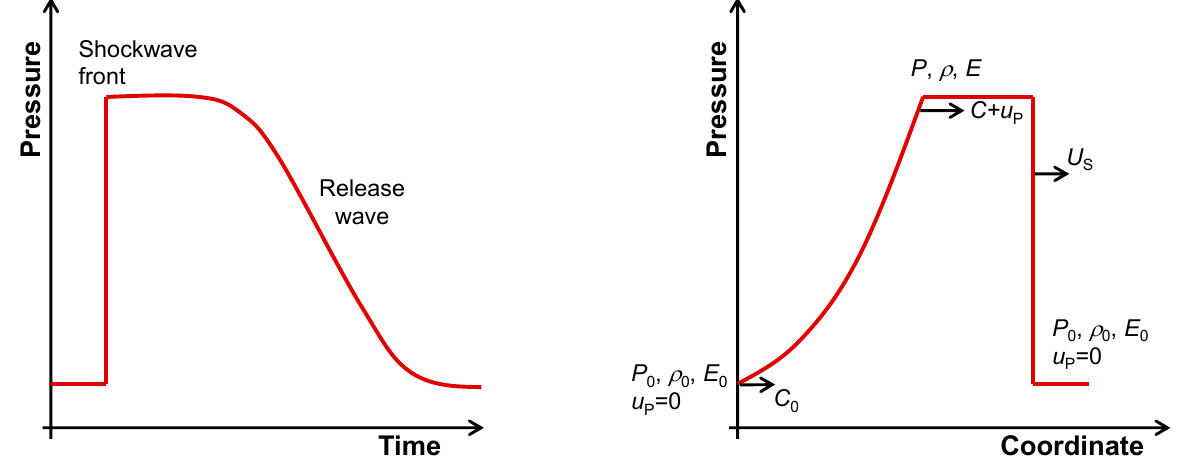
Figure 3. Pressure profile in case of plate impact: in function of time ( left ) and spatial coordinate ( right ). P , ρ , E , C , and U p identify respectively pressure, density, energy, speed of sound, and particle velocity of a point belonging to the shocked material; P 0 , ρ 0 , E 0 , C 0 , and U p 0 identify pressure, density, energy, speed of sound, and particle velocity in the undisturbed material, respectively; U s is the shock front velocity with C + U p > U s